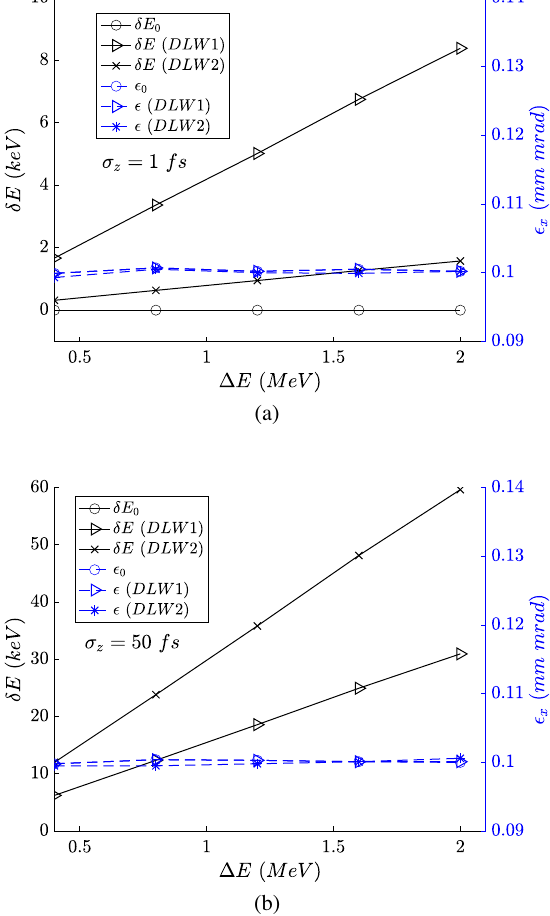
FIG. 15. Scaling of single-stage and multistage performance with energy gain per stage. (a) Slice energy spread and emittance, (b) projected energy spread and emittance for a 50 fs beam ( α ¼ 40 ). δ E 0 and ϵ 0 are initial energy spread and emittance at